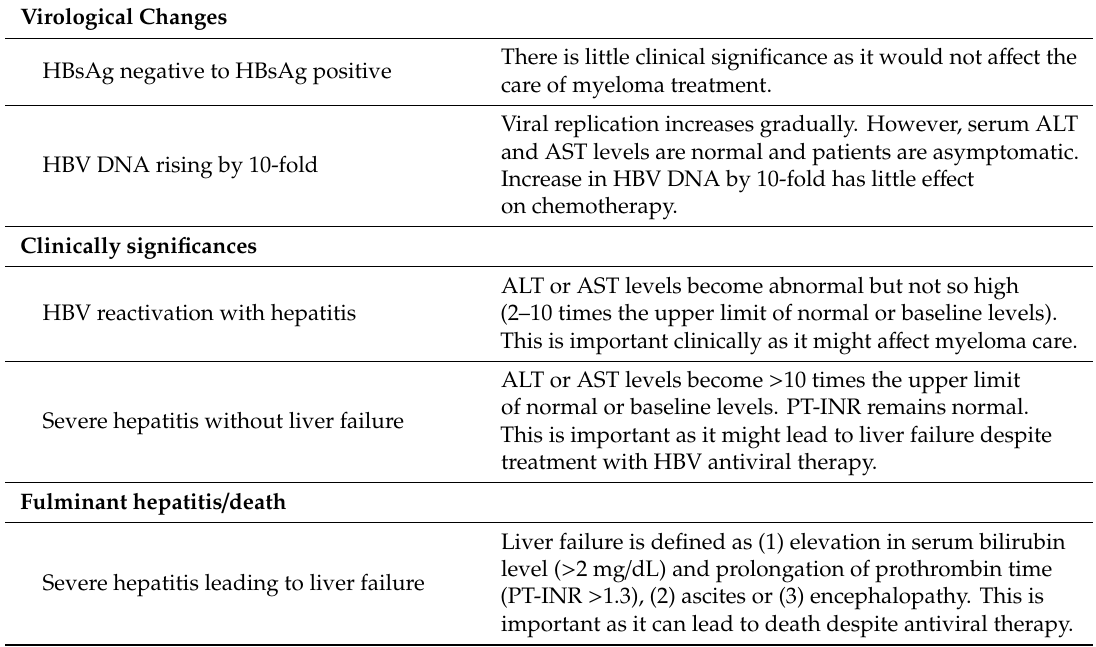
Table 1. Phases of HBV reactivation